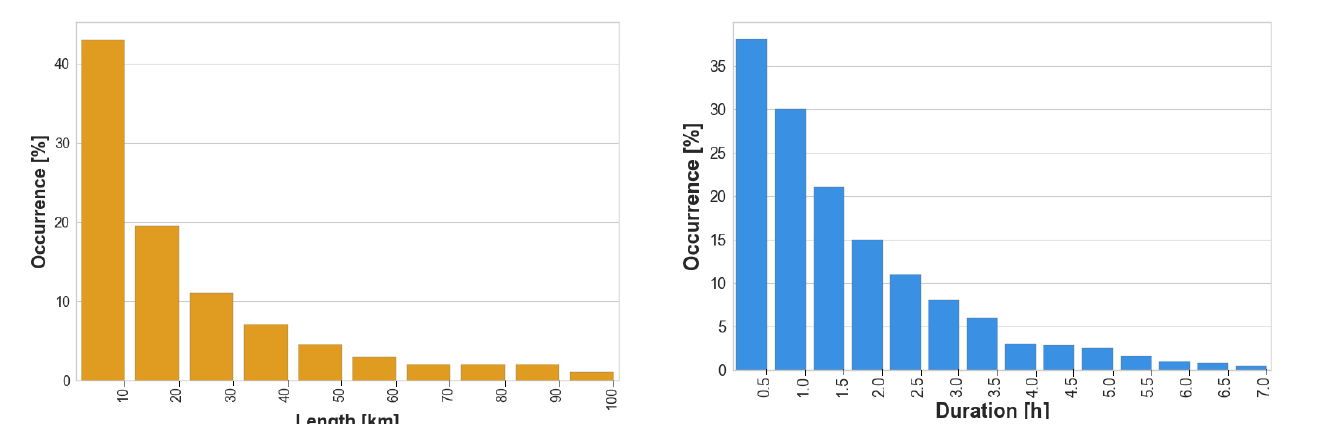
Figure 9. Histogram of all SCS mean lengths.